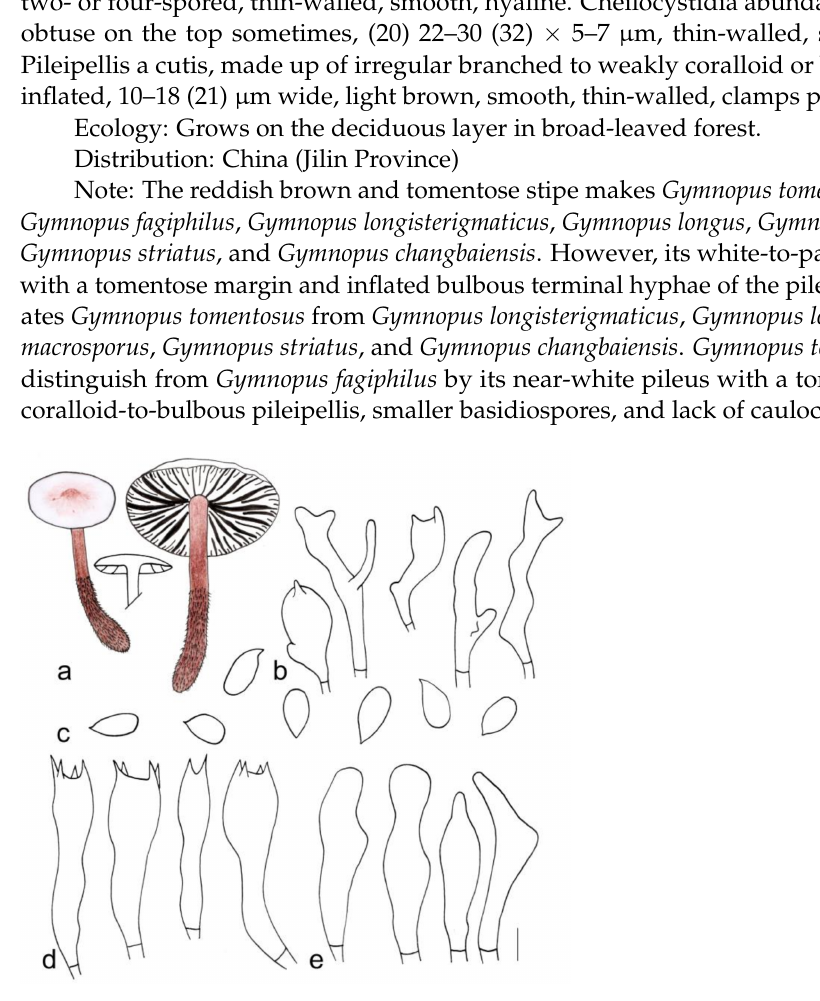
Figure 9. Morphological characteristics of Gymnopus tomentosus (HMJAU 60303,